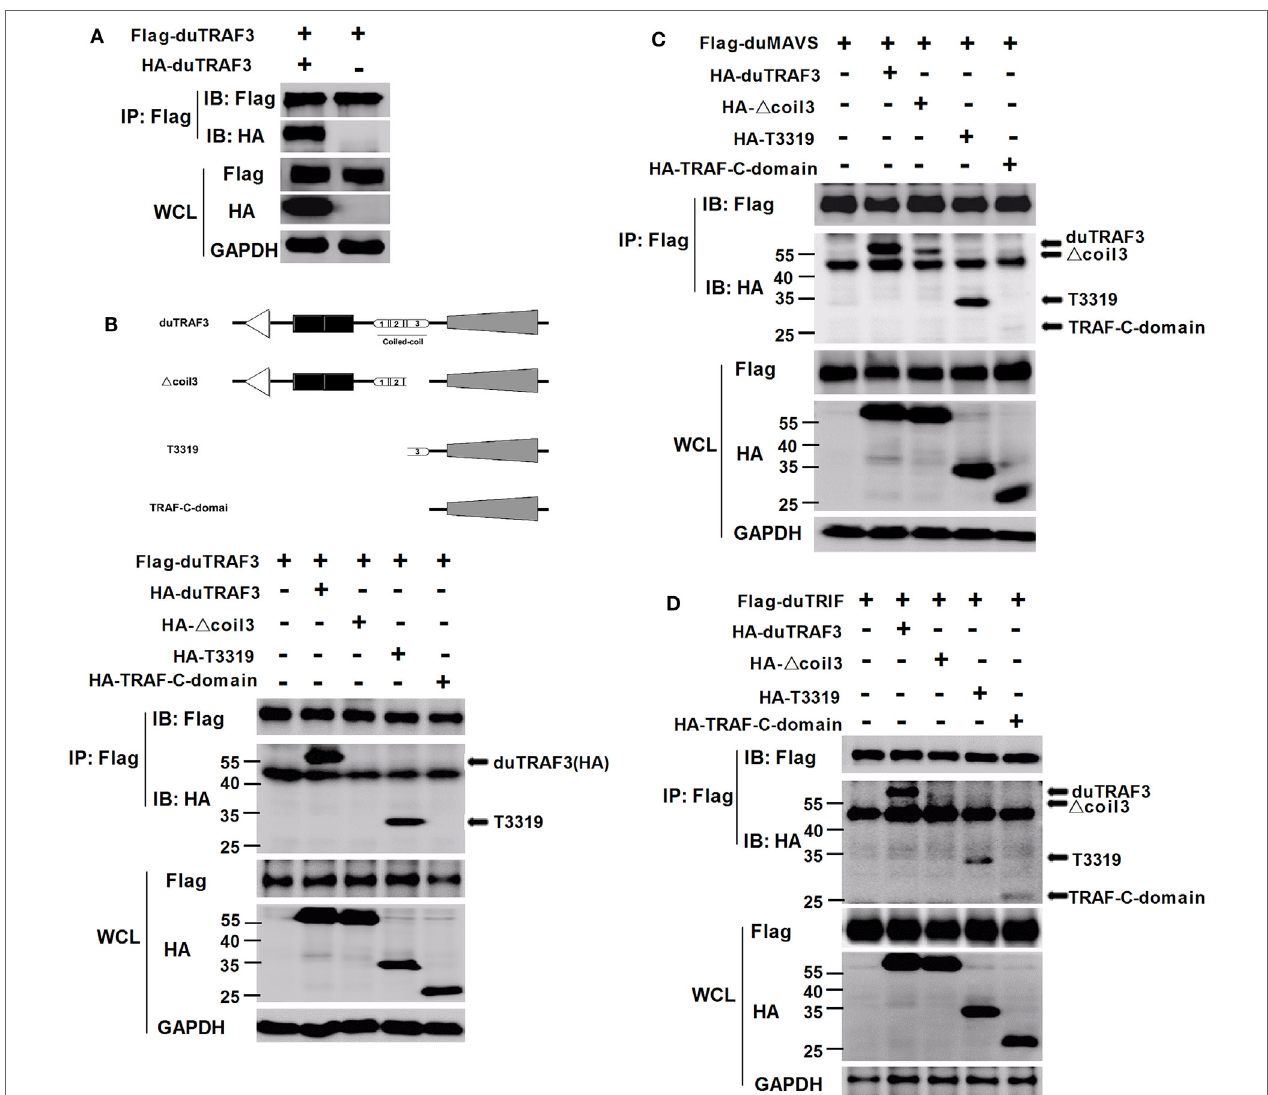
FigUre 6 | Duck TRAF3 (duTRAF3) self-association requires its coil 3 region and is required for the binding of duTRAF3 to duMAVS or duTRIF. (a) 293T cells were cotransfected with Flag-duTRAF3 and HA-duTRAF3. (B) Schematic map of the duTRAF3 and the deletion mutants [duTRAF3, Δ coil 3, T3319, and conserved C -terminal domain of TRAF (TRAF-C-domain)]. 293 T cells were transfected with Flag-duTRAF3 together with HA-duTRAF3, HA- Δ coil 3, HA-T3319, or HA-TRAF-C- domain. (c,D) 293T were cotransfected with Flag-duMAVS (c) or Flag-duTRIF (D) together with HA-tagged duTRAF3 or duTRAF3 truncation forms. Twenty-four hours after transfection, cells were collected and subjected to immunoprecipitation with anti-Flag. The immunoprecipitation complexes were analyzed by western blotting using anti-Flag and anti-HA